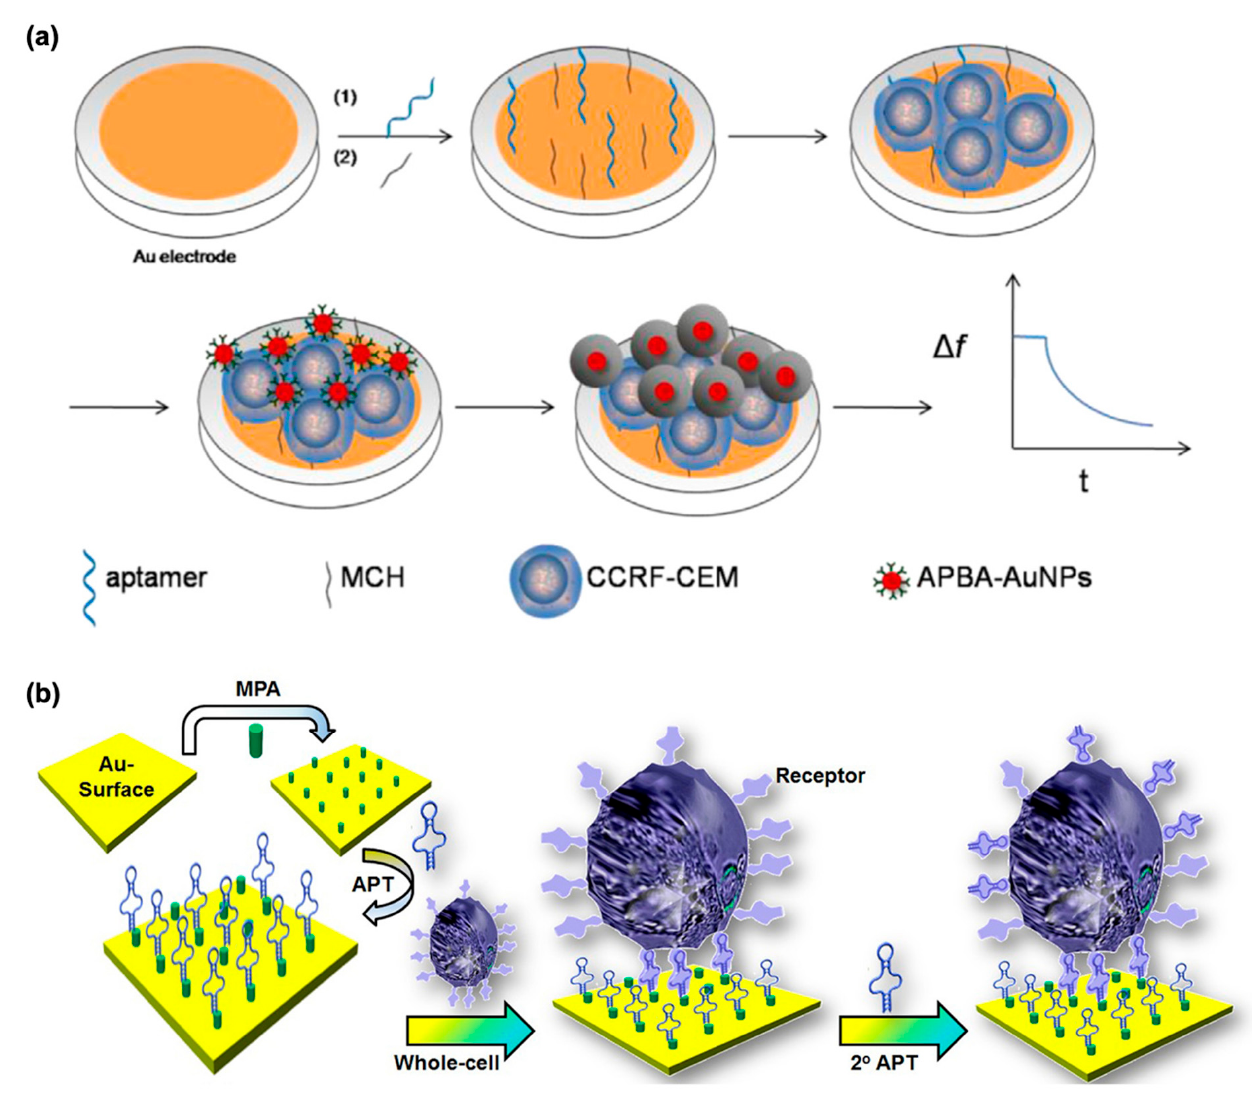
Figure 8. ( a ) Design of QCM aptasensor for detection of leukemia cells, reprinted with permission from Ref. [140] 2014, Shan. ( b ) Capture of HepG2 Cells on aptamer immobilized QCM gold surface electrode, reprinted permission from Ref. [141] 2014, Kashefi-Kheyrabadi.